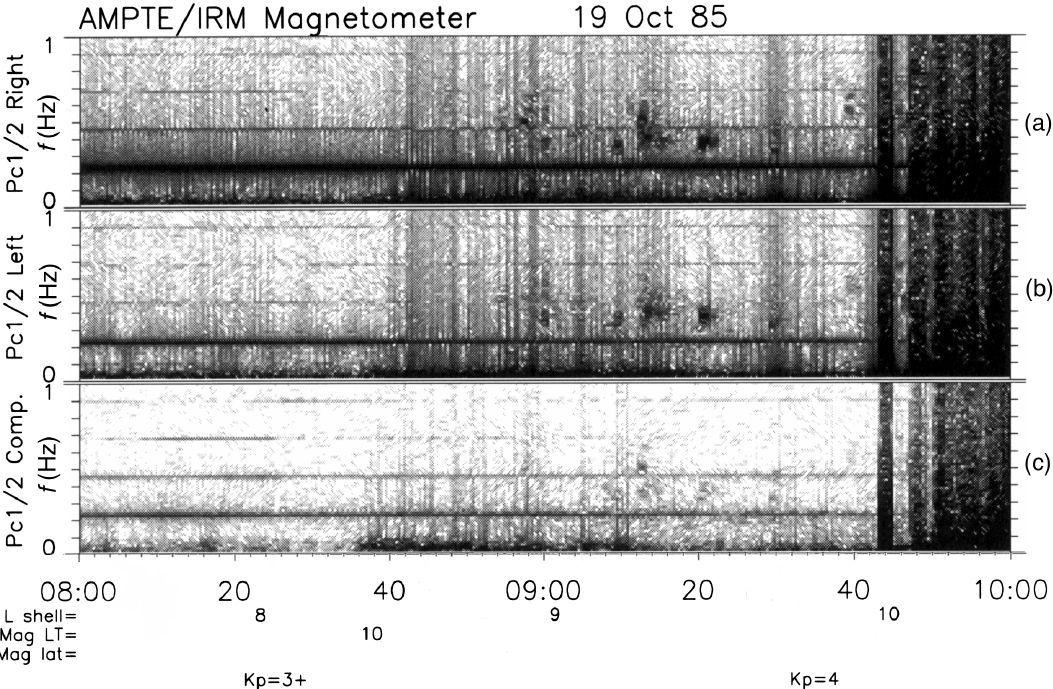
Fig. 1. Survey spectrogram of right-hand polarized (top panel), left-hand polarized (middle panel), and compressional (bottom panel) Pc 1 waves detected by the IRM flux-gate magnetometer on 19 October 1985. In this example, Pc 1 waves occur starting at 08:54UT and continue to be detected intermittently until the IRM passes into the magnetosheath at about 09:48UT. The strong line at 0.22Hz is due to satellite spin and should be